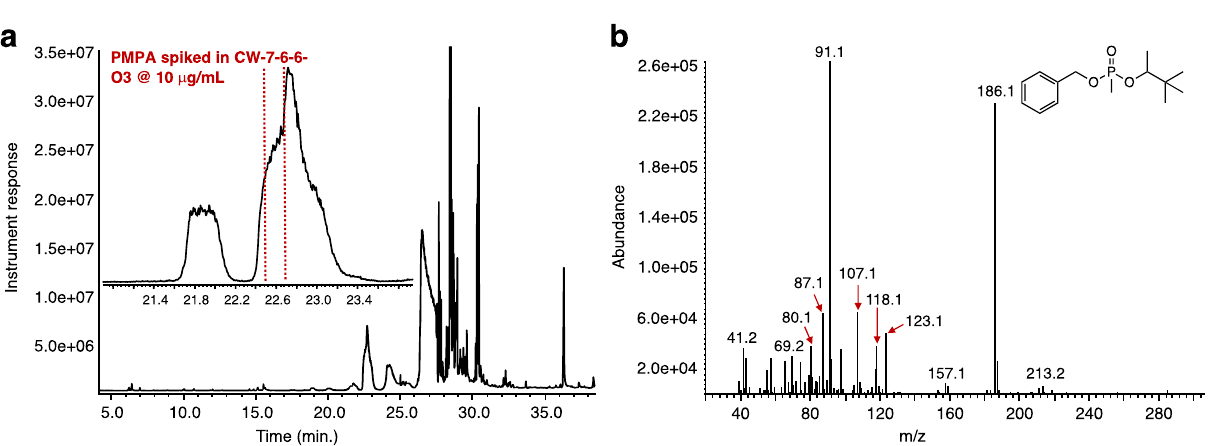
Figure 6. GC–MS analysis on fatty acid-rich matrix CW-O3 spiked with PMPA at ~ 10 μg/mL concentration. ( a ) GC chromatogram of CW-7-6-6-03 matrix after reaction with benzyl 2,2,2-trichloroacetimidate. A clear signal of the product BPMPA cannot be observed due to numerous interferences in the matrix, even after extracting selected ions (m/z = 91, 186; inset). ( b ) Mass analysis of the area indicated by the red dotted lines in Fig. 5a inset yields the mass spectrum for